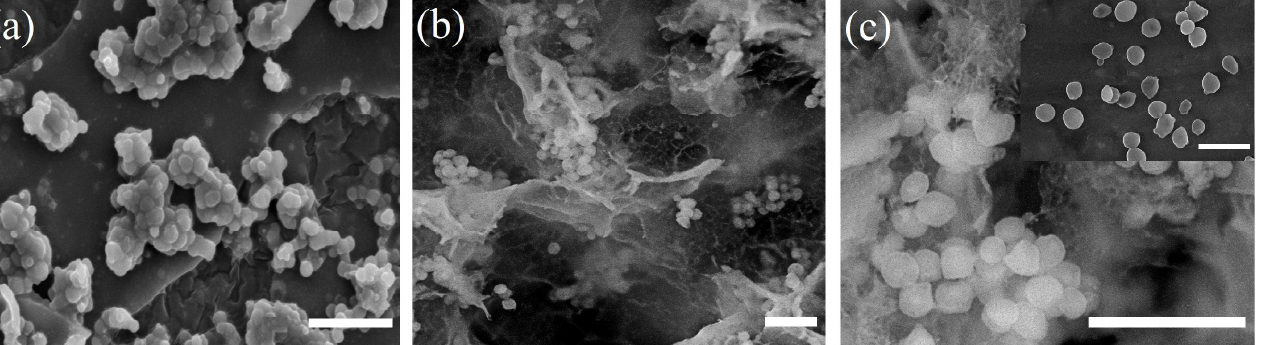
Figure 6. SEM micrograph showing the formation of a 3D structure: ( a ) biohybrid material based on Ogataea polymorpha VKM Y-2559 cells encapsulated in an organosilica SP EG -composite, ( b , c ) biohybrid material based on Ogataea polymorpha VKM Y-2559 cells encapsulated in an organosilica STP EG - composite, and insert free Ogataea polymorpha VKM Y-2559. The bar represents a 5 µ m